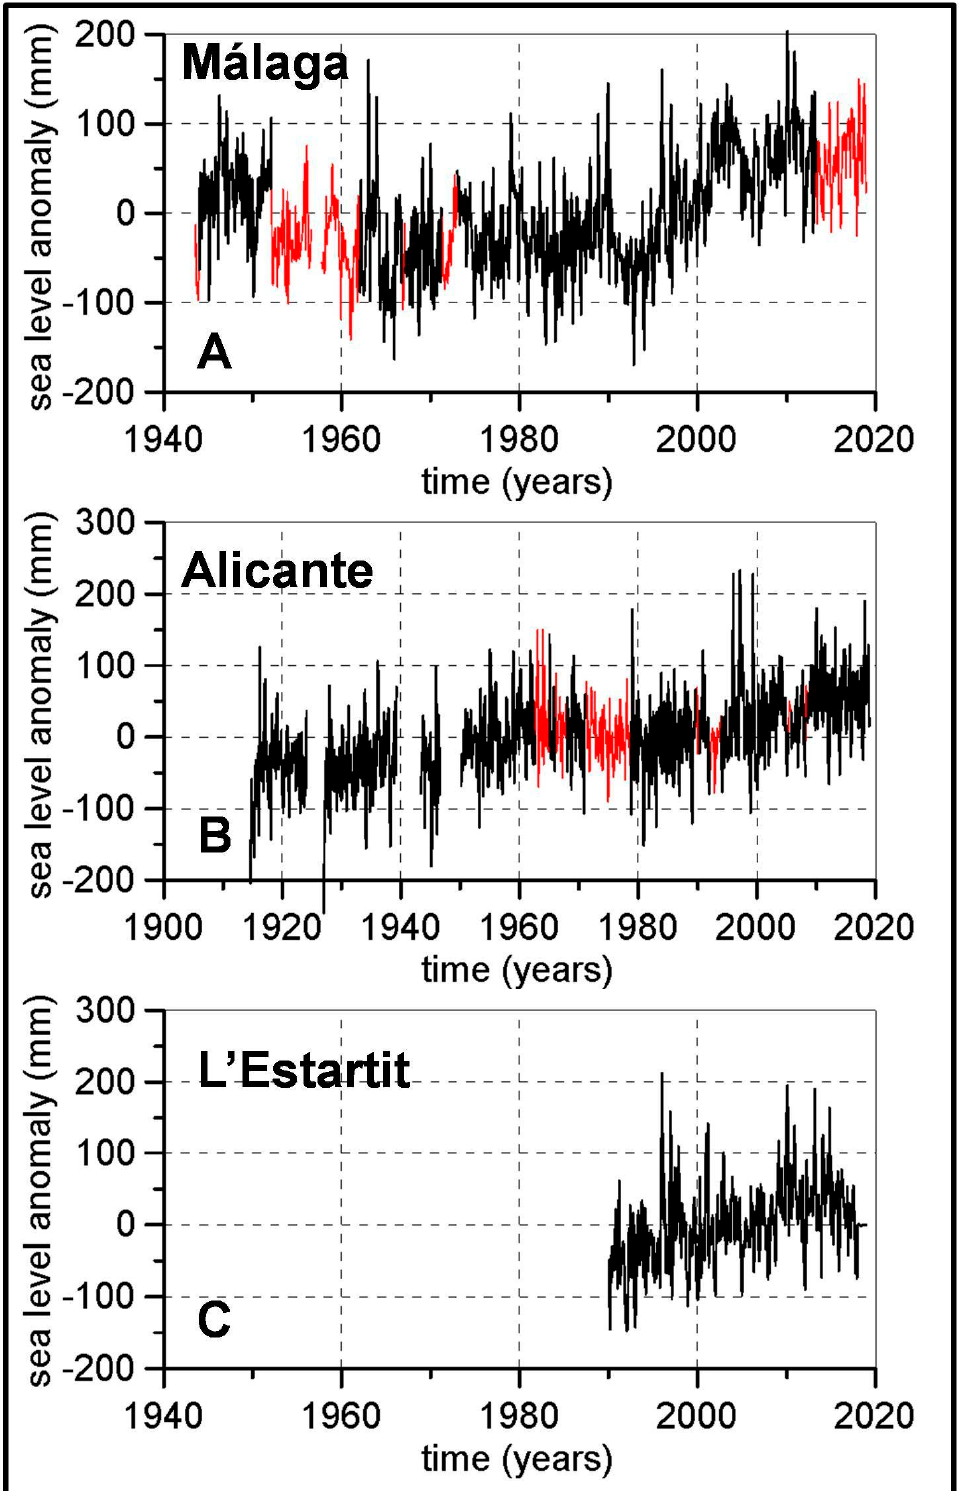
Figure 5. Observed and reconstructed sea level anomalies for Málaga, Alicante and L’Estartit. Black lines in ( A – C ) are the time series of anomalies (observed minus seasonal cycle) at Málaga, Alicante, and L’Estartit. Red lines in ( A , B ) are the time series of anomalies of sea level where gaps have been filled using nearby stations.